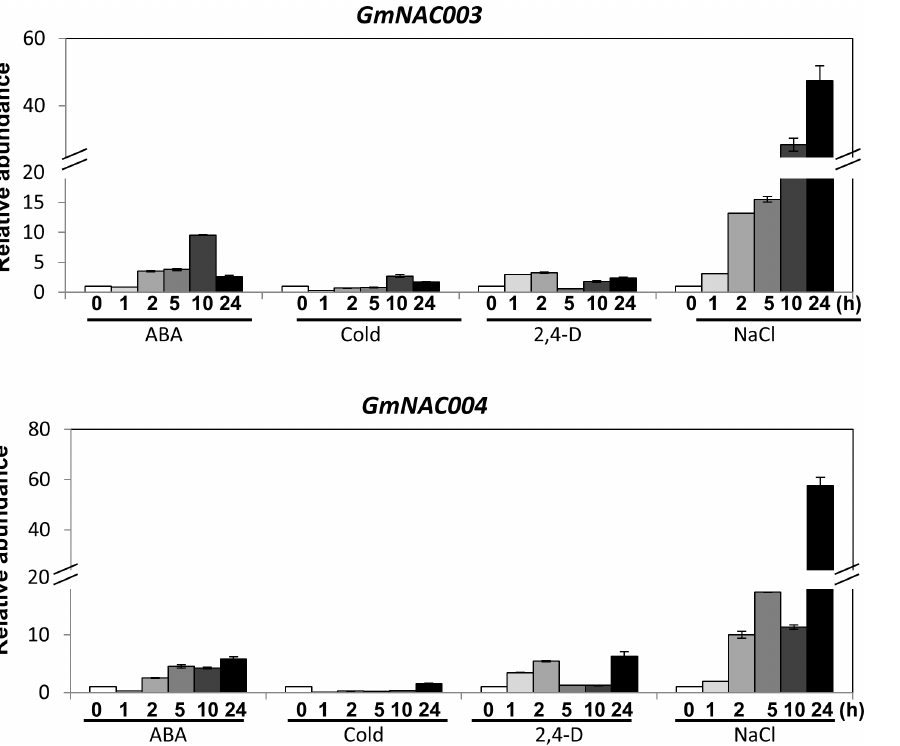
Figure 2. Expression of GmNAC003 and GmNAC004 in response to various stresses and hormonal treatments. V2 growth-stage soybean plants were harvested and transferred to stress conditions. All treatments of control (Water), 20 nM 2,4-D (2,4-D), 100 m M ABA (ABA), 4 u C (Cold) and 250 mM NaCl (NaCl) were under hydroponic conditions at 28 u C unless otherwise indicated. Transcript abundance was quantified by qRT-PCR and the data were normalized to the four most stable internal reference genes ( CYP2, IDE, UNK1 and UNK2 ) using GeNorm. Data were normalized using water treatments, and transformed to a value of 1 for the unstressed plant (0 h). The error bars are standard errors of the means (n=3 plants).